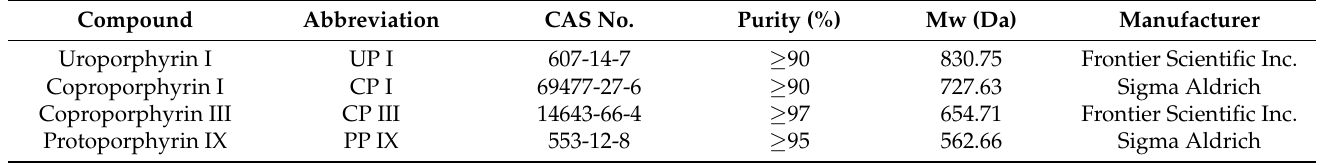
Table 6. Porphyrin reagents used to prepare standard porphyrin solutions in the